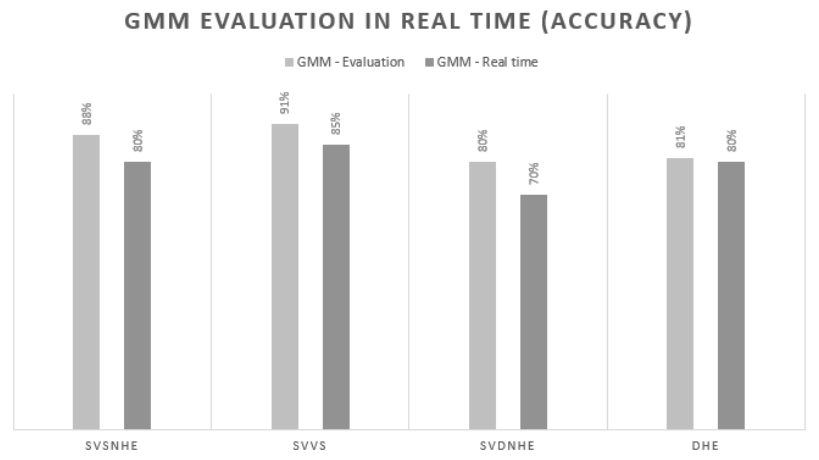
Figure 23. Results of GMM in real